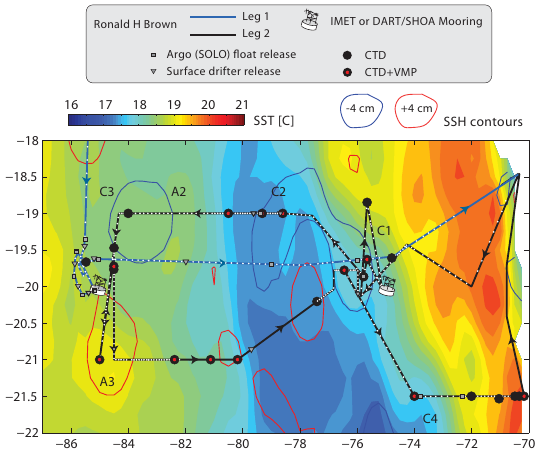
Fig. 9. Cruise tracks for Legs 1 and 2 of the NOAA R/V Ron Brown during VOCALS-Rex superimposed on the sea-surface tempera- ture (SST) and sea-surface height (SSH) from November 18th 2008 (middle of Leg 2; courtesy of P. Gaube and D. Chelton, OSU). The 438 underway CTDs (UCTD) are overlaid as white dots on the two tracks. Also shown are the locations of the 35 CTDs and 15 VMP (microstructure) profiles as well as those where 19 surface drifters and 10 profiling SOLO floats were deployed. Several of the sampled cyclones and anticyclones are indicated by a C and A, respectively, followed by a sequential